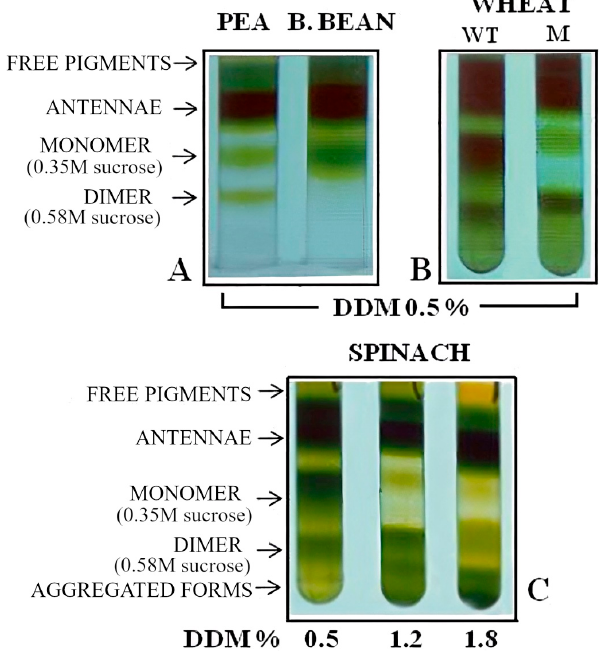
Figure 1. Photosystem II (PSII) particles were isolated from various species as indicated, and applied in sucrose gradient ultracentrifugation (SGU) as reported in the Material and Methods. For the gradients in A and B, the particles were solubilized at a concentration of 1 mg of Chlorophyll (Chl) in 0.3 mL 0.5% of n-dodecyl- β -d-maltoside (DDM). ( A ) Pea and broad bean PSII particles fractionation into free pigment–protein complexes, antennae, monomer at 0.35 M sucrose and dimer at 0.58 M sucrose. ( B ) Wheat and yellow-green wheat PSII particles fractionation into free pigment–protein complexes, antennae, monomer at 0.35 M sucrose and dimer at 0.58 M sucrose. ( C ) Spinach PSII particles fractionation into free pigment–protein complexes, antennae, monomer at 0.35 M sucrose and oligomeric aggregated cores. For the gradient in ( C ), 1 mg Chl of spinach particles were solubilized in 1 mL of increasing detergent concentration: 0.5%, 1.2%, 1.8% DDM. The experiments were repeated at least four times for each species, and a typical figure is presented.